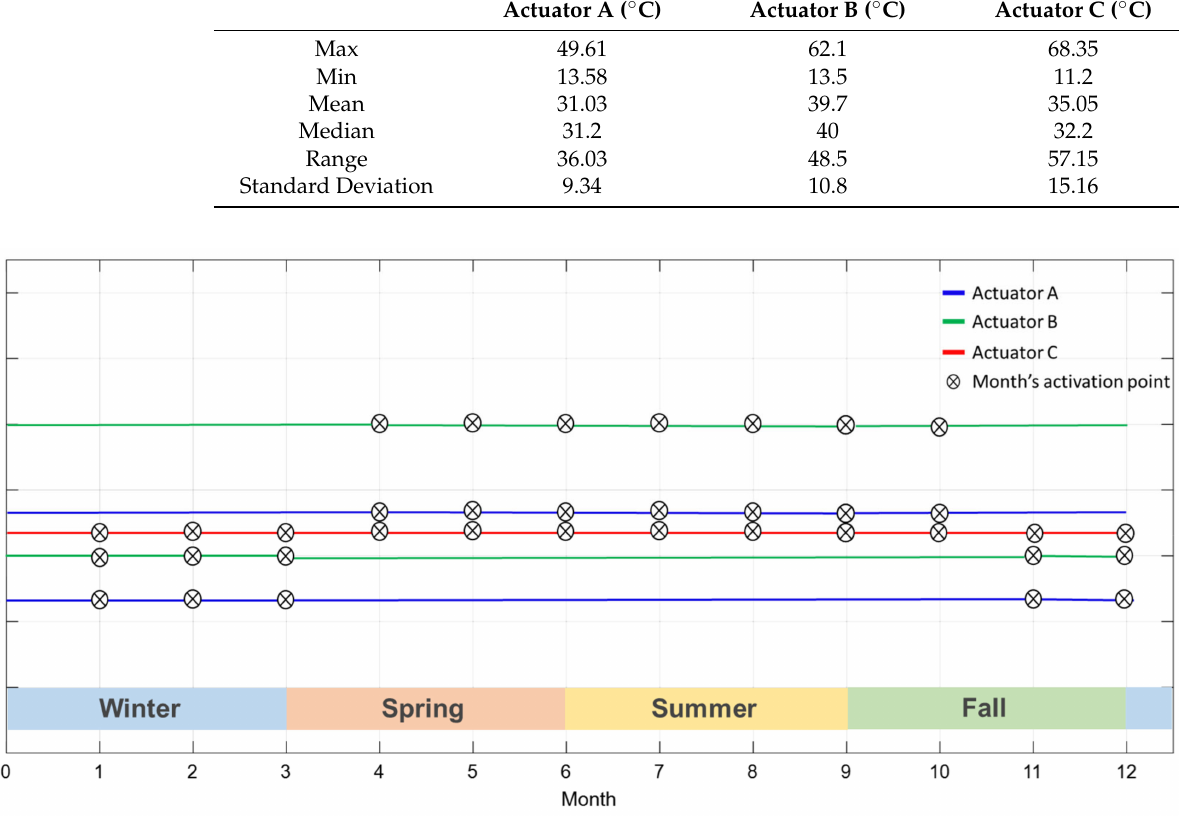
Figure 14. Activation temperature lines for the proposed three